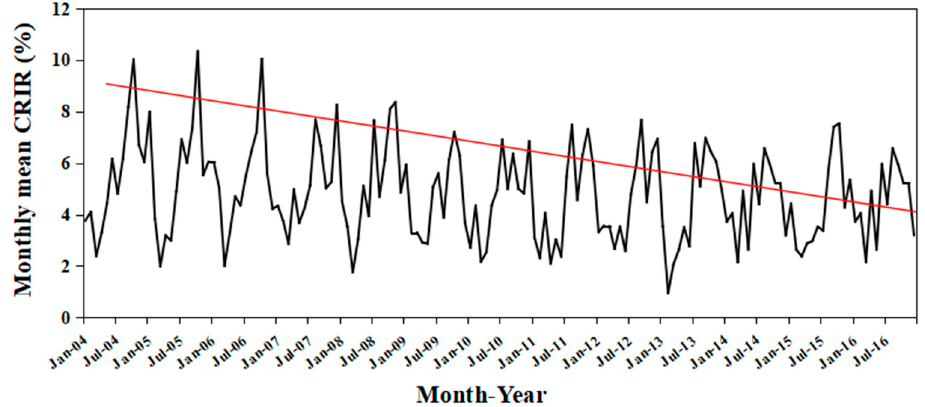
Figure 7. Variation of monthly mean canopy rainfall interception rates in Guangdong.